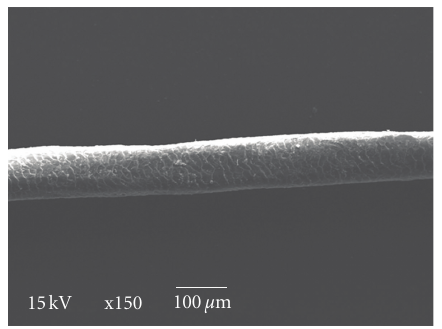
Figure 2: Untreated Egyptian white wool fiber ( × 150).